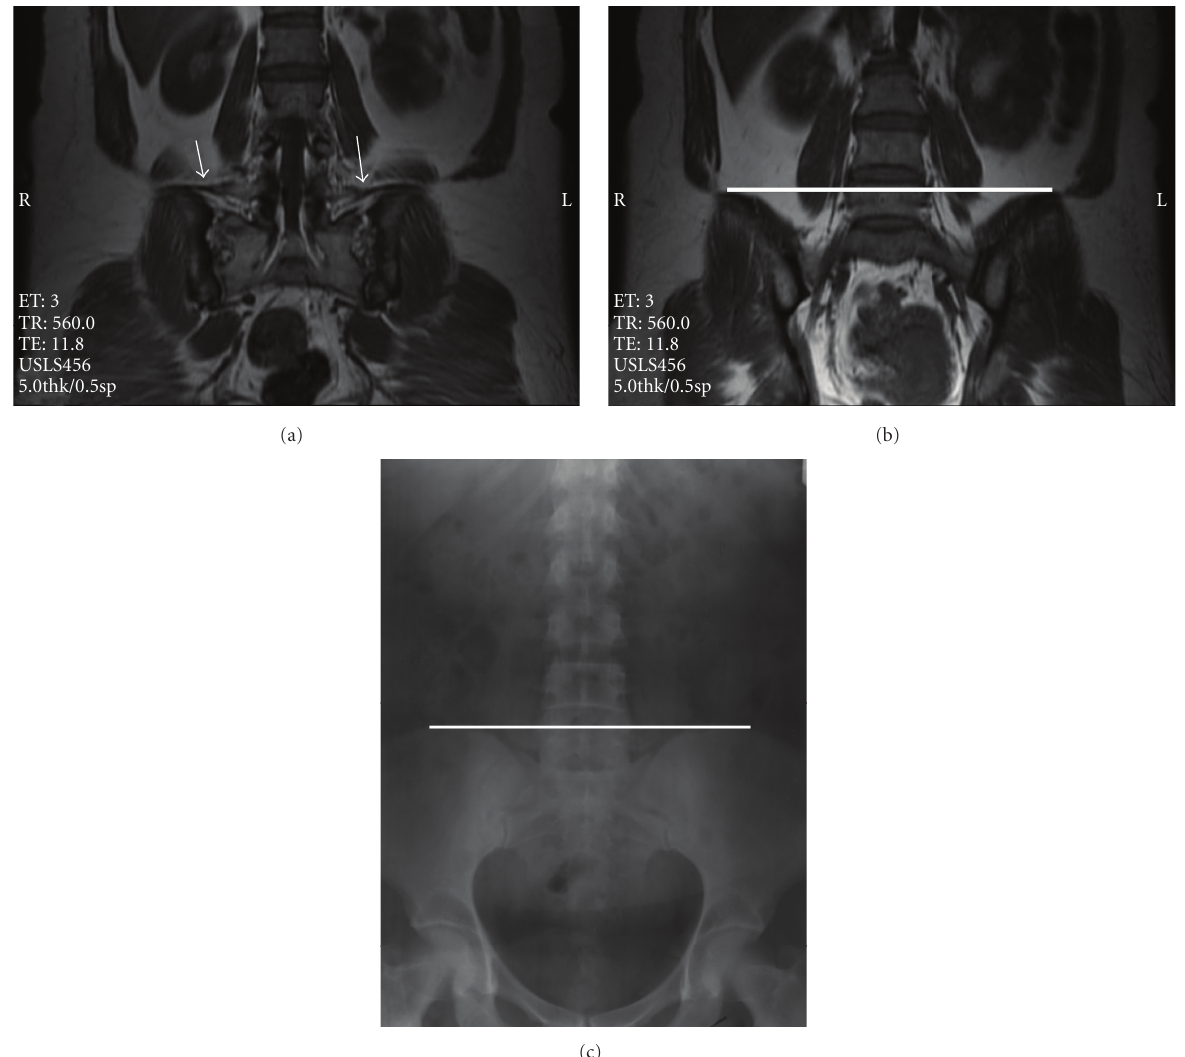
Figure 2: (a) Iliolumbar ligament (arrow) was used to identify L5 vertebra. (b) Coronal MRI showing Tu ffi er’s line at the level of L5 upper segment. (c) Anteroposterior lumbosacral X-ray of the same patient which shows Tu ffi er’s line at the same level.